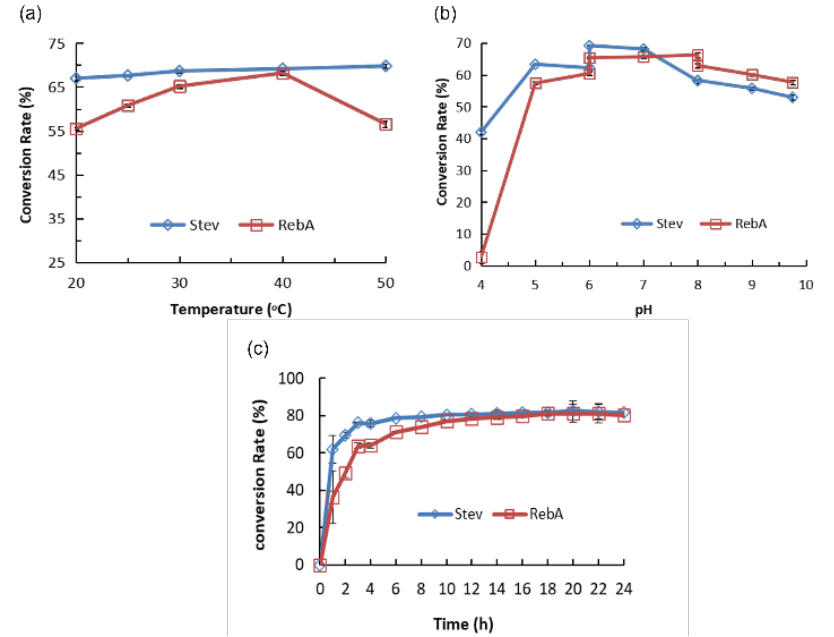
Figure 4. Effect of temperature ( a ), pH ( b ), and incubation time ( c ) on the conversion rate of Stev and Reb A to glucosylated steviol glycosides catalyzed by